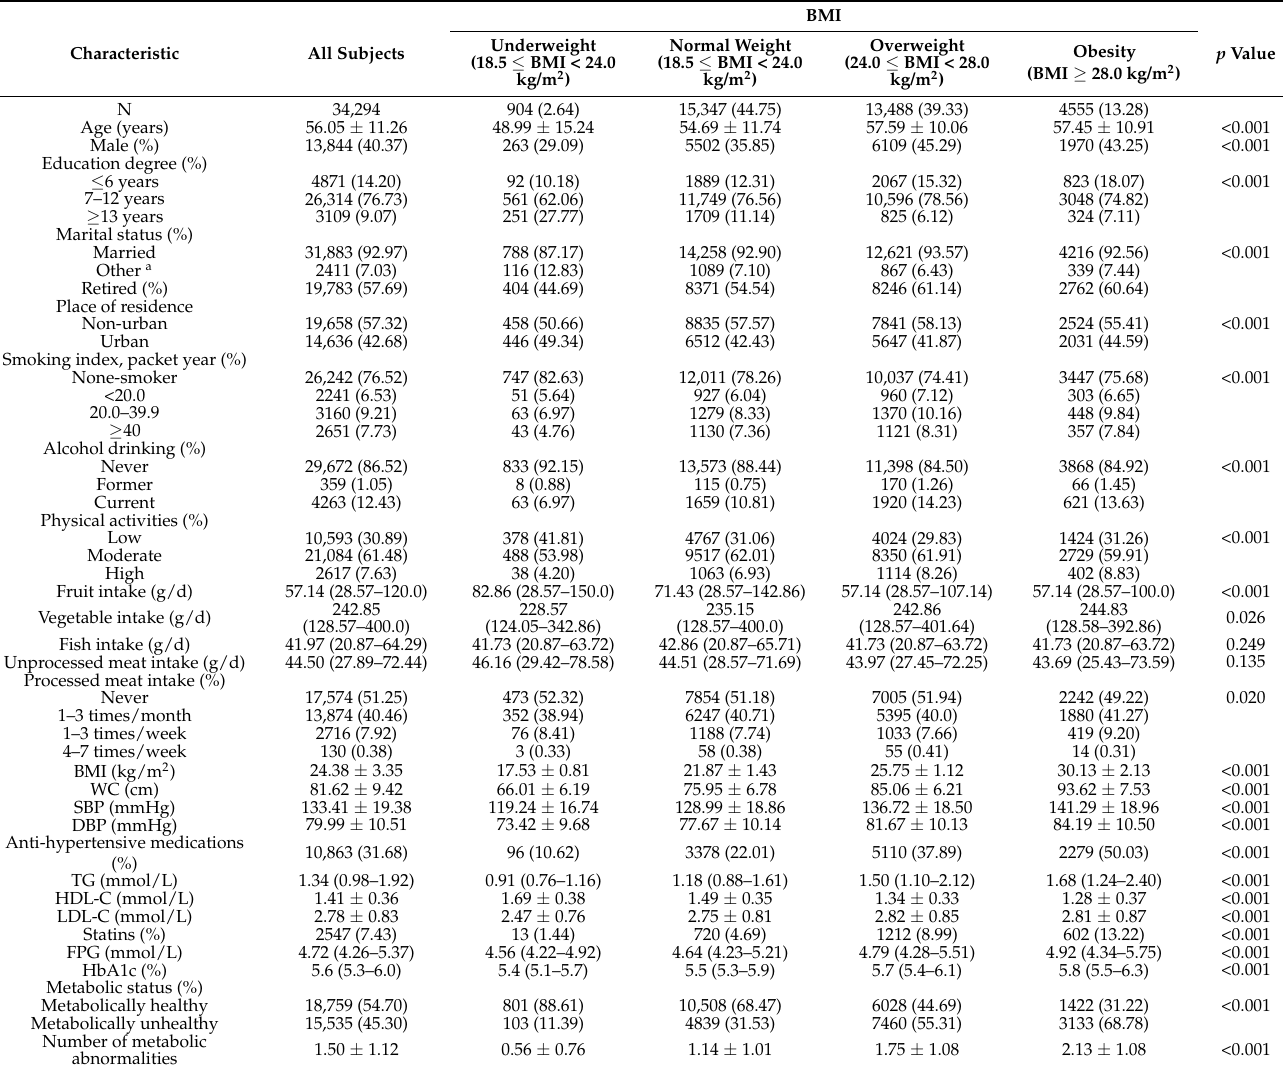
Table 1. Characteristics of the study participants according to